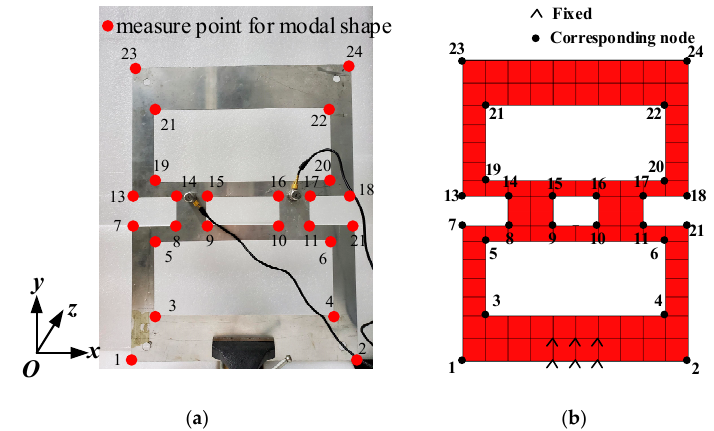
Figure 17. Measurement of modal shapes: ( a ) Experimental model; ( b ) FE model.